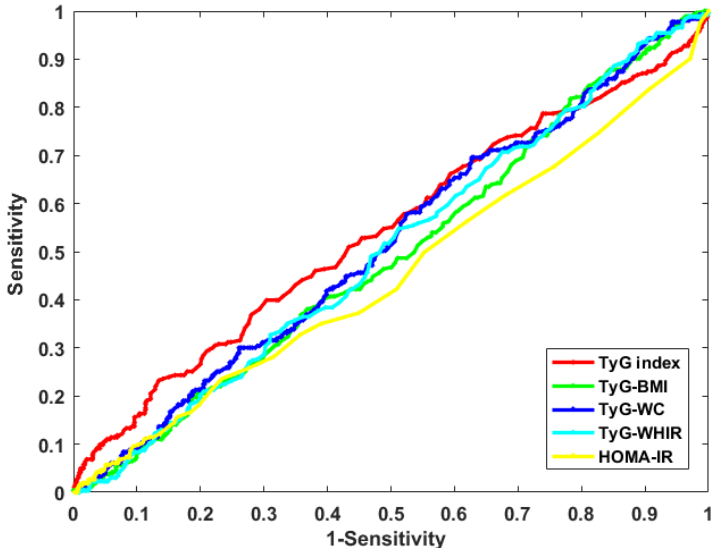
Figure 3. The ROC curves of the TyG index, TyG-WC, TyG-BMI, TyG-WHtR and HOMA-IR